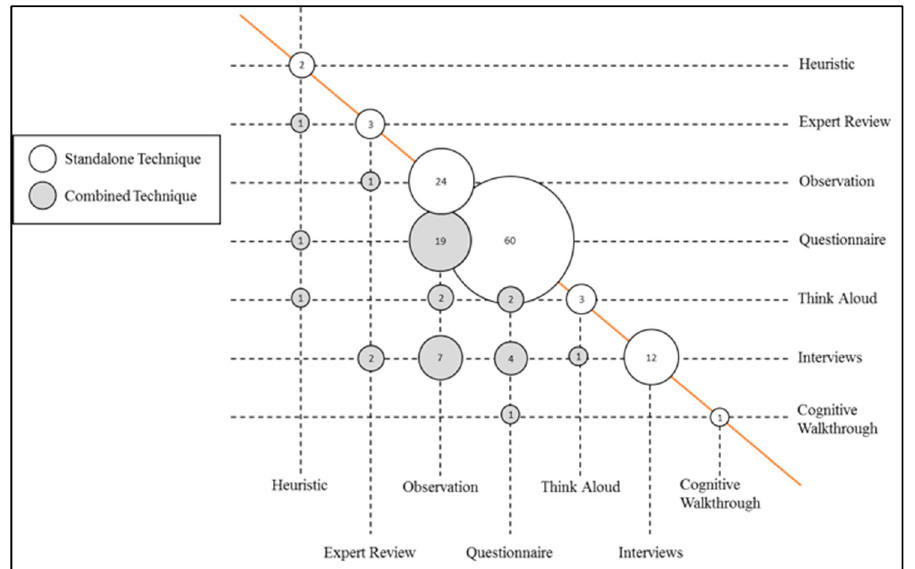
Figure 13. Frequency of correlated techniques.